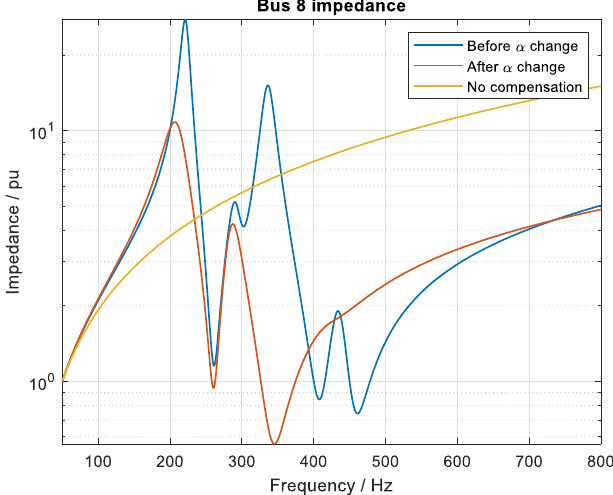
Figure 15. The 7th harmonic frequency parallel resonance mitigation in bus 8.